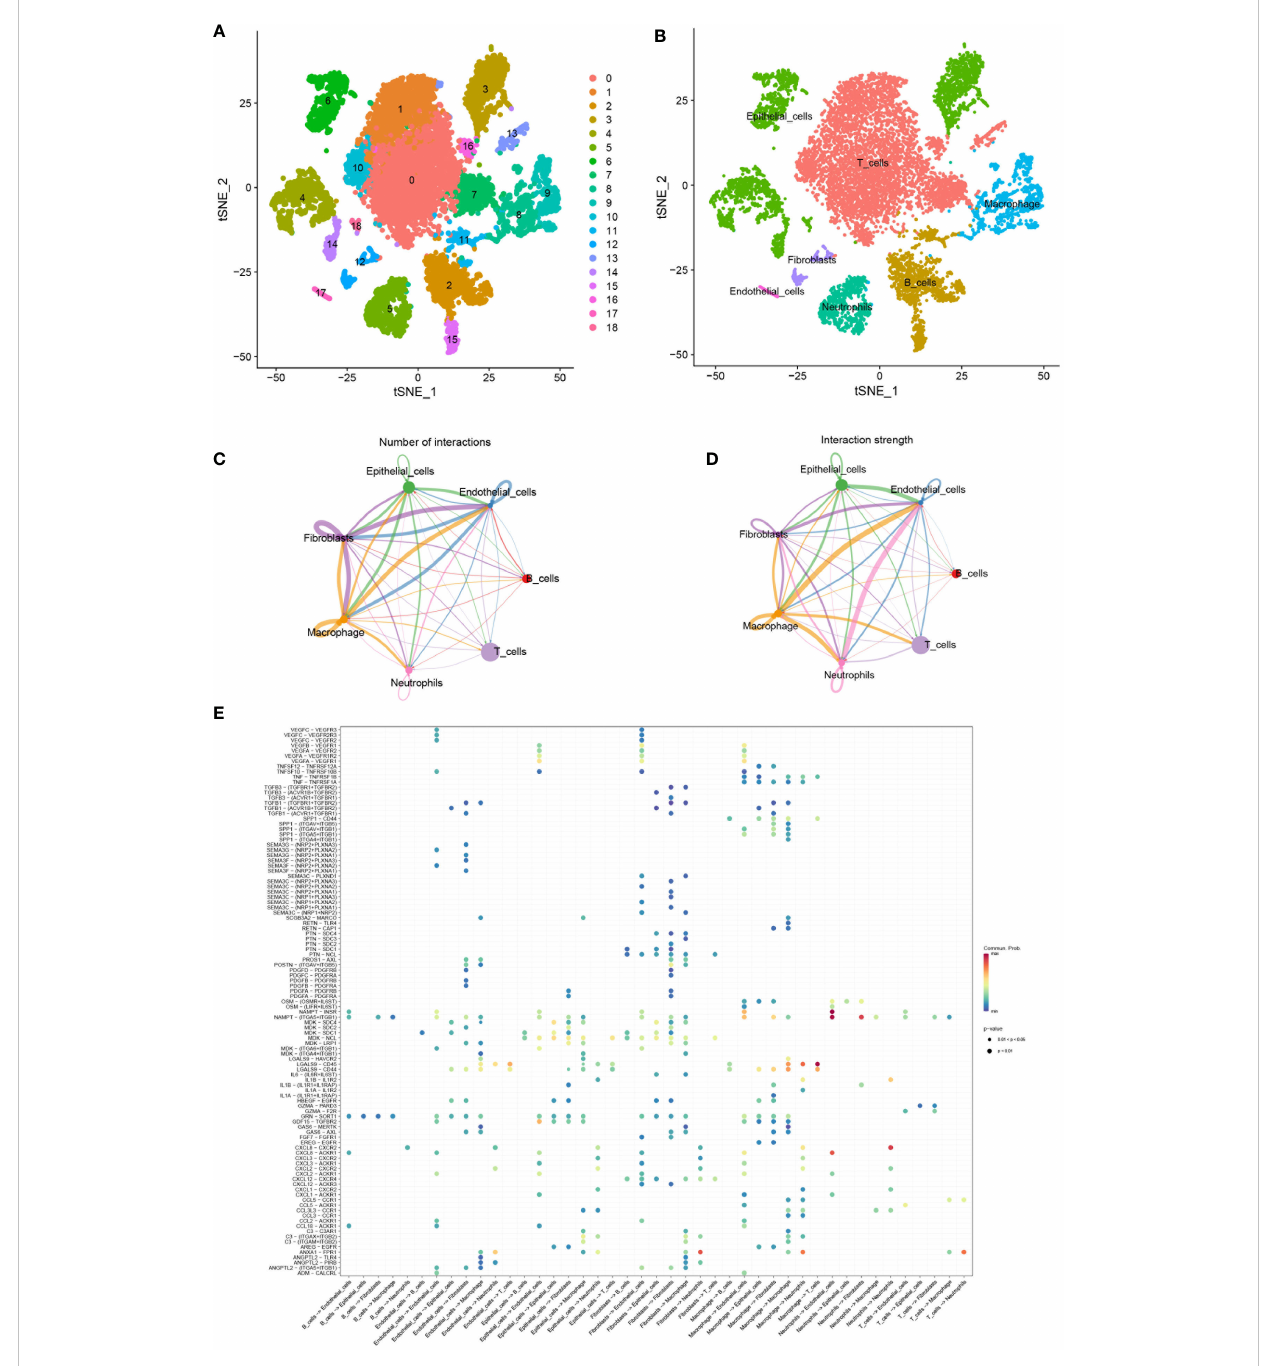
role in this signaling pathway and other interacting ligand-receptor pairs include SPP1- a v b 1 integrin, SPP1- a v b 5 integrin (Figure 9D). Figure 9E also indicated the intercellular communication probability, which means that a higher frequency of information exchange between macrophages and fi broblasts is often achieved through the SPP1 signaling pathway. And the expression of ligand-receptor